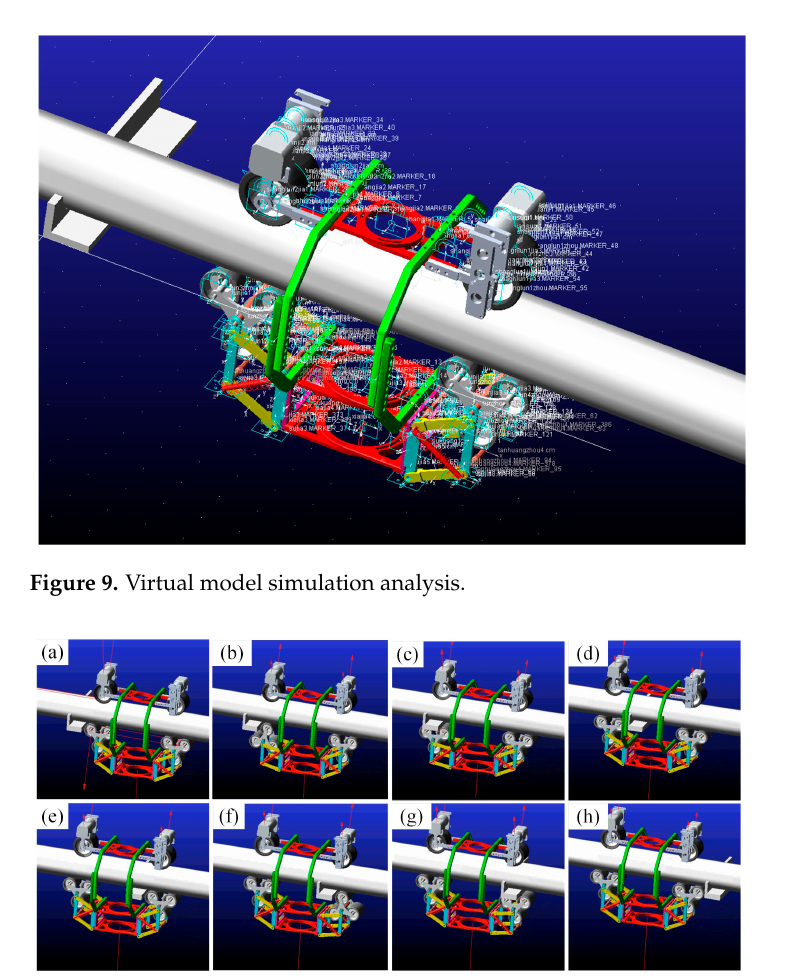
Figure 10. Simulation process of obstacle surmounting by the robot: ( a – d ) Obstacle surmounting by the front composite wheel; ( e – h ) Obstacle surmounting by the rear composite wheel.